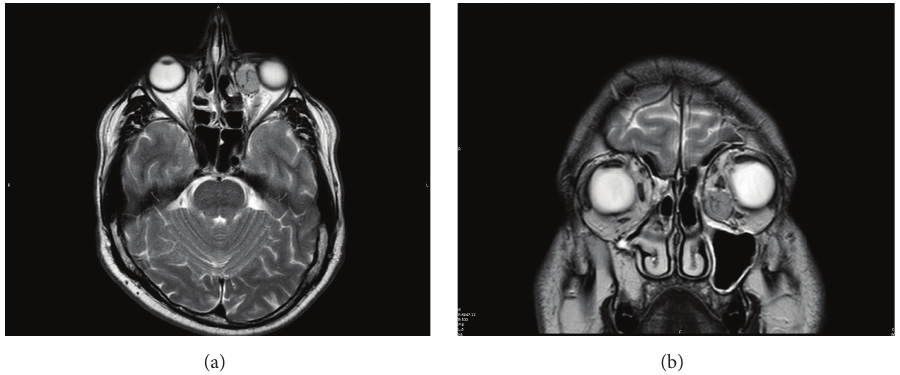
Figure 1: RMI: (a) Coronal T2 MRI scan shows an oval, encapsulated, vascularized, inferomedial, and extraconal mass in the left orbit. The mass displaces the eyeball and the inferior rectus muscle laterally and the medial rectus muscle cranially. (b) Axial T2 MRI scan shows the mass located in the anterior part of the left extraconal medial orbit.